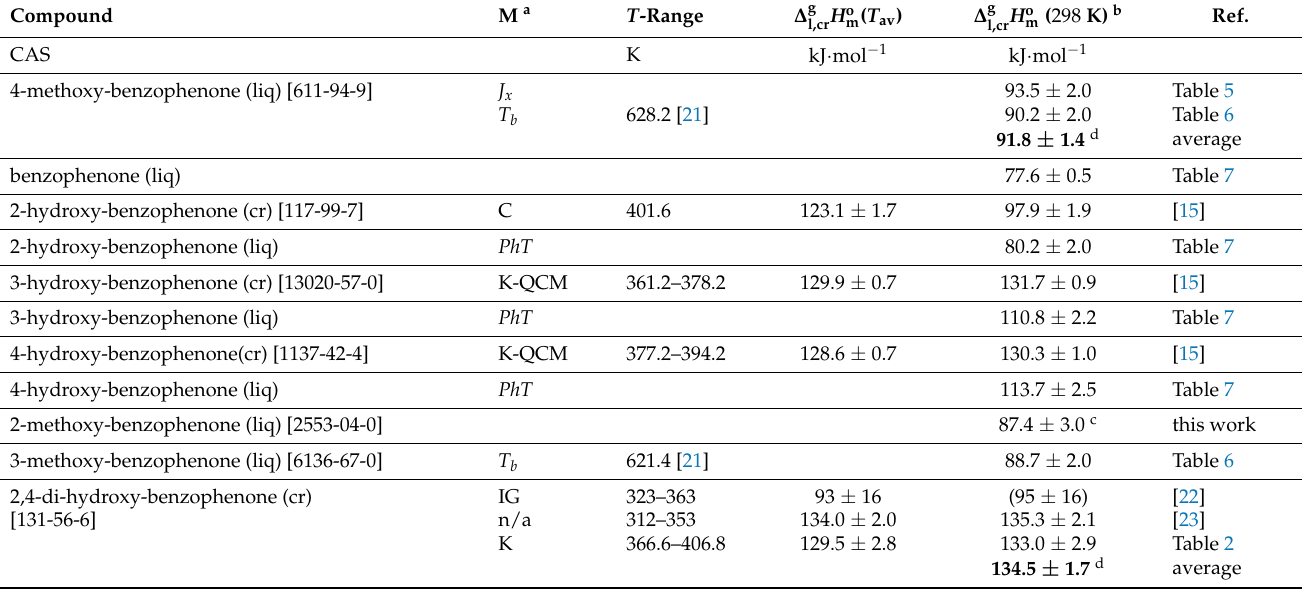
Table 4. Compilation of enthalpies of vaporisation/sublimation ∆ g derivatives derived in this work and from the data available in the